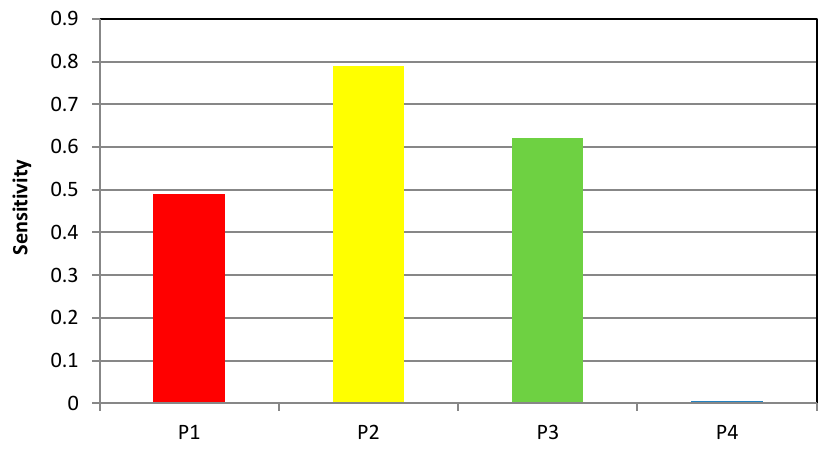
Figure 9. Sensitivities of parameters P1–P4, described in Table 4.